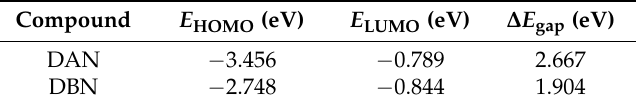
Figure 8. Frontier molecule orbital density distribution and optimized structures of DAN (a-structure; b-HOMO; c-LUMO) and DBN (d-structure; e-HOMO; f-LUMO). Table 4. Quantum parameters for DAN and DBN a .